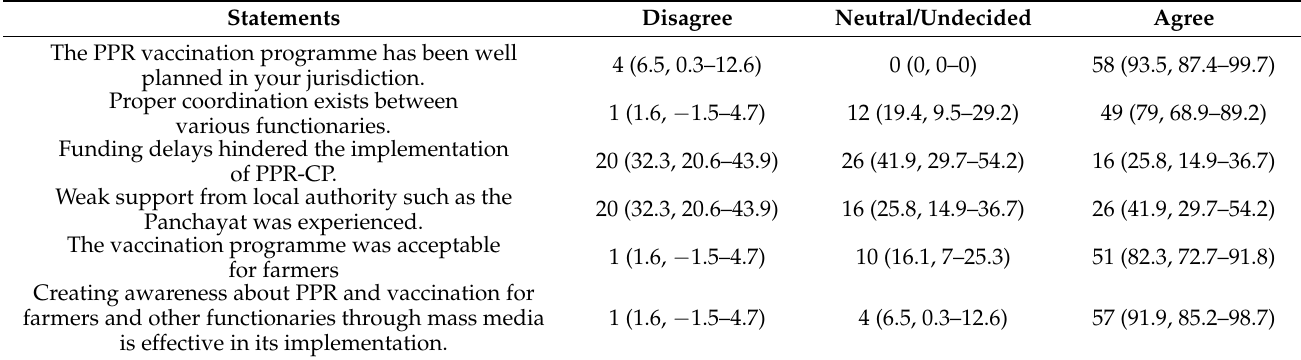
Table 4. Survey results on the perceptions of veterinarians regarding the planning and rollout of the PPR control programme (PPR-CP) in Karnataka ( N = 62).